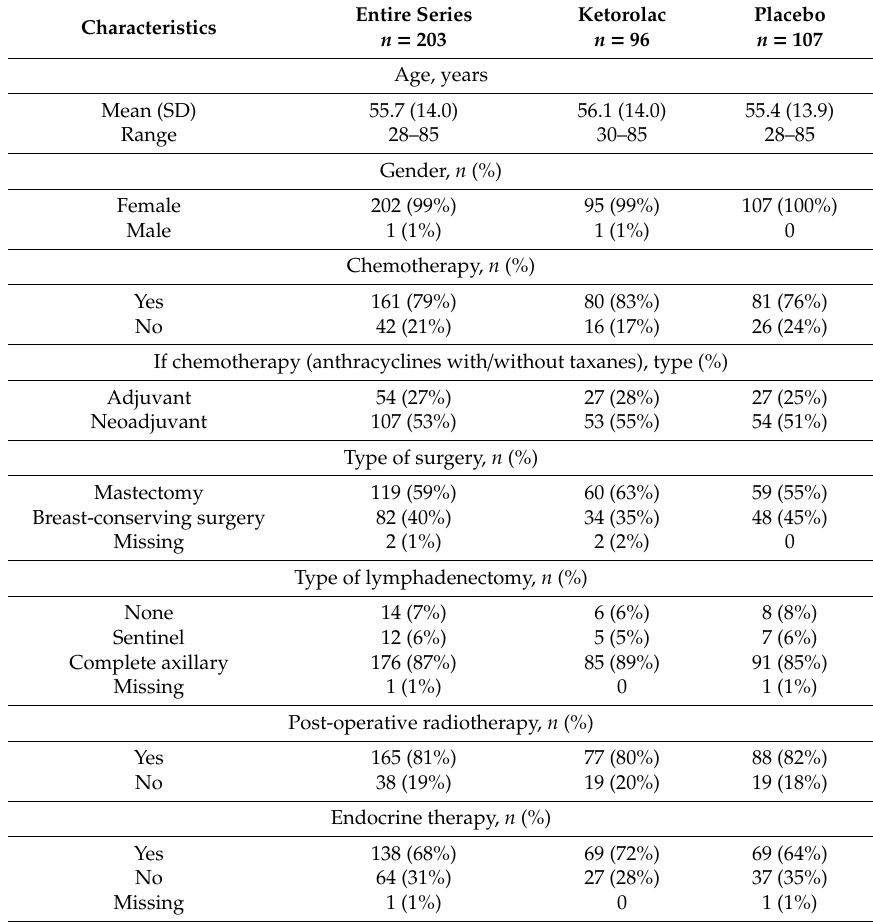
Table 1. Baseline characteristics of the patients, tumours, and treatments (adapted from Forget